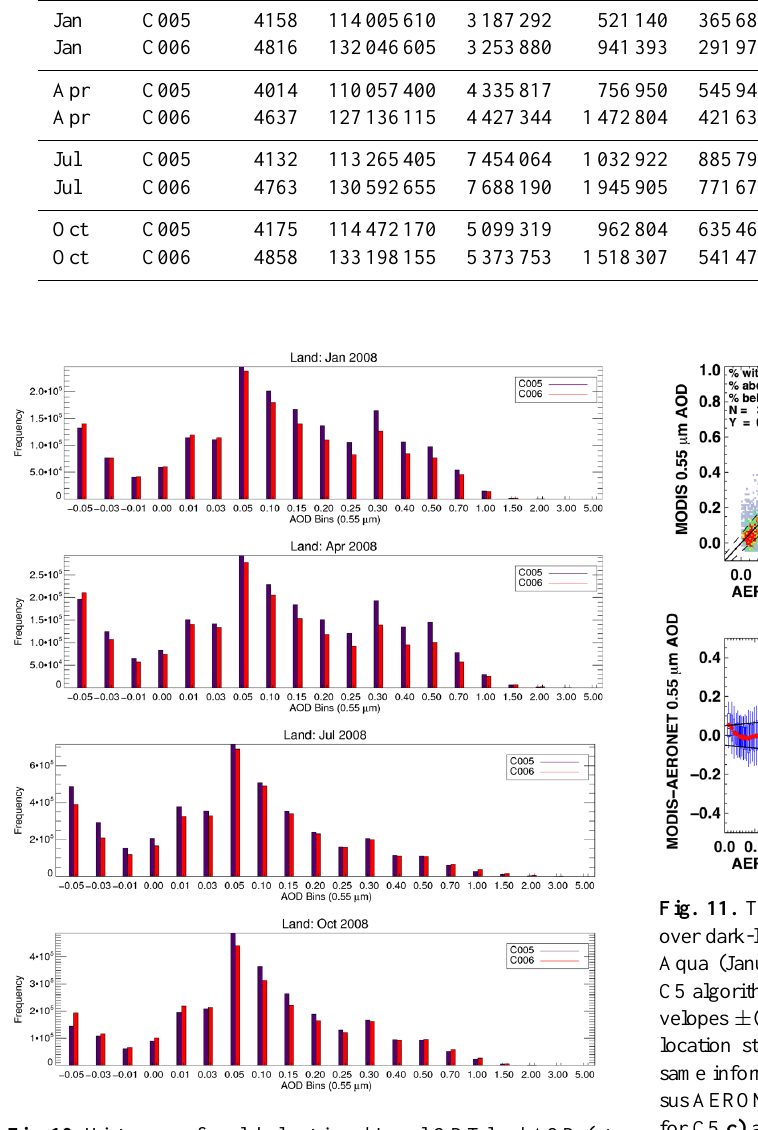
Fig. 10. Histograms for global retrieved Level 2 DT-land AOD (at 0.55µm) from Aqua for four months. Plotted are data from C5 and C6.